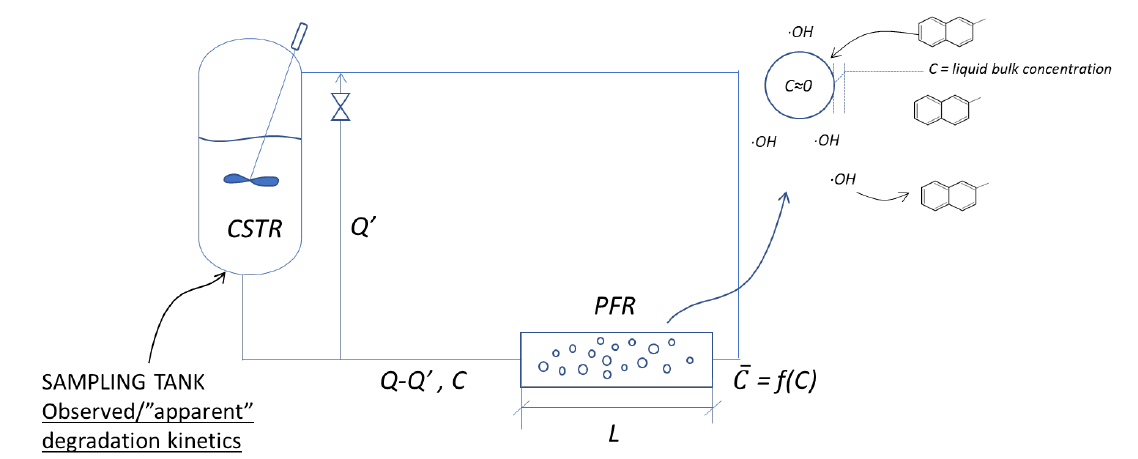
Figure 3. Reactor model for the kinetics estimation.